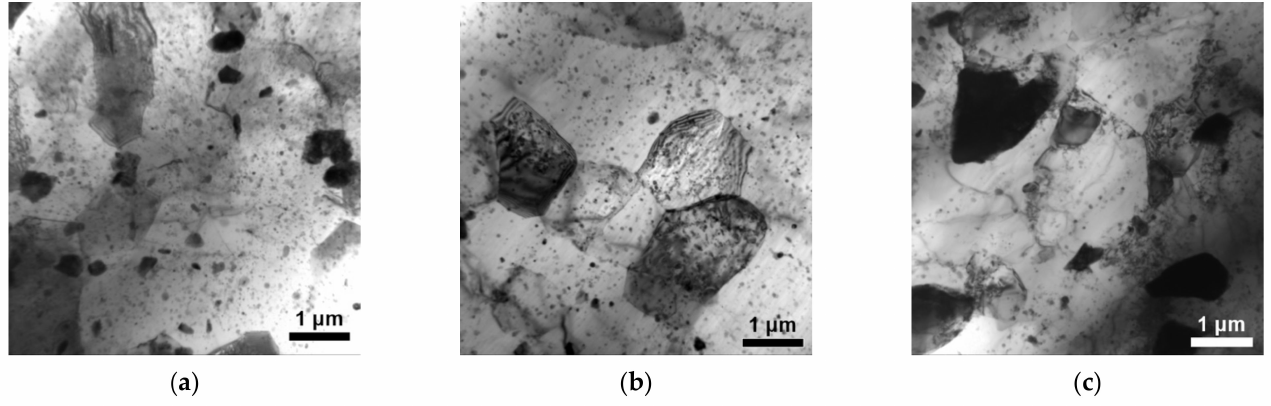
Figure 8. Light-field TEM images of the stir zone of samples ( a ) 5.4, ( b ) 10.4 and ( c )